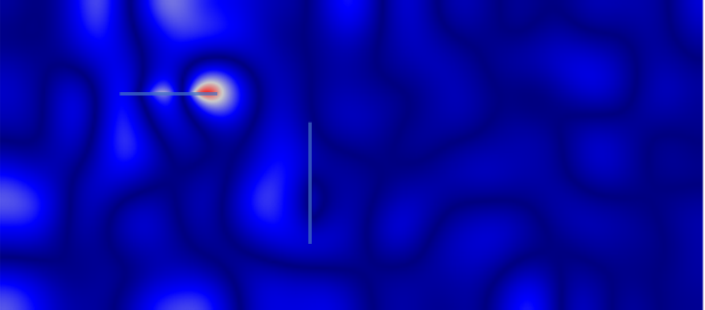
Figure 8. Absolute pressure on the whole domain at time 1.208ms. Beams are plotted with light blue color. The defect is clearly revealed at the right end of the horizontal beam.